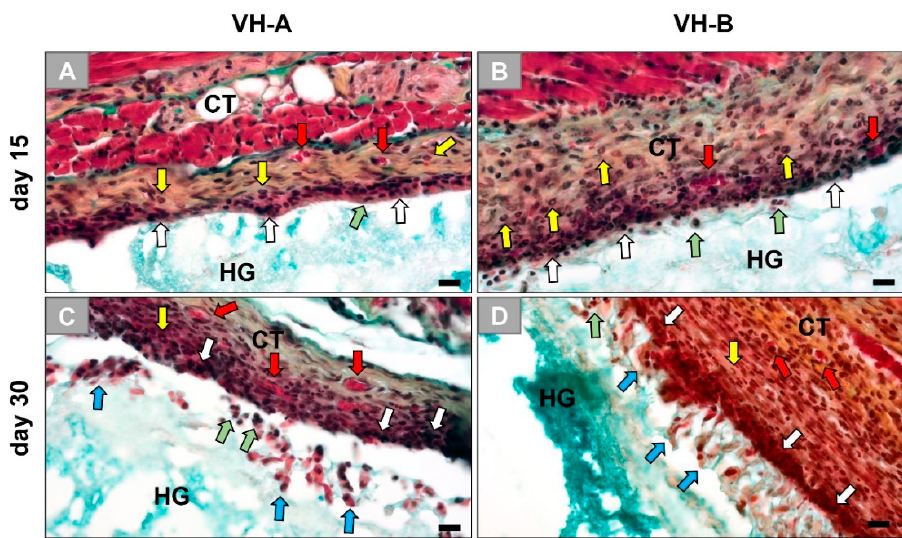
Figure 1. Exemplary histological images of the subcutaneously implanted hydrogels (VH-A and VH-B) at day 15 and 30 post implantation. ( A ) VH-A hydrogel and ( B ) VH-B hydrogel at day 15. ( C ) VH-A hydrogel and ( D ) VH-B hydrogel at day 30. CT = connective tissue, HG = hydrogel, white arrows = macrophages, green arrows = neutrophils, yellow arrows = eosinophils, red arrows = blood vessels and blue arrows = infiltration cells of the reactive tissue (Movat Pentachrome stainings, magnification = 400 × scalebars = 20 µm).